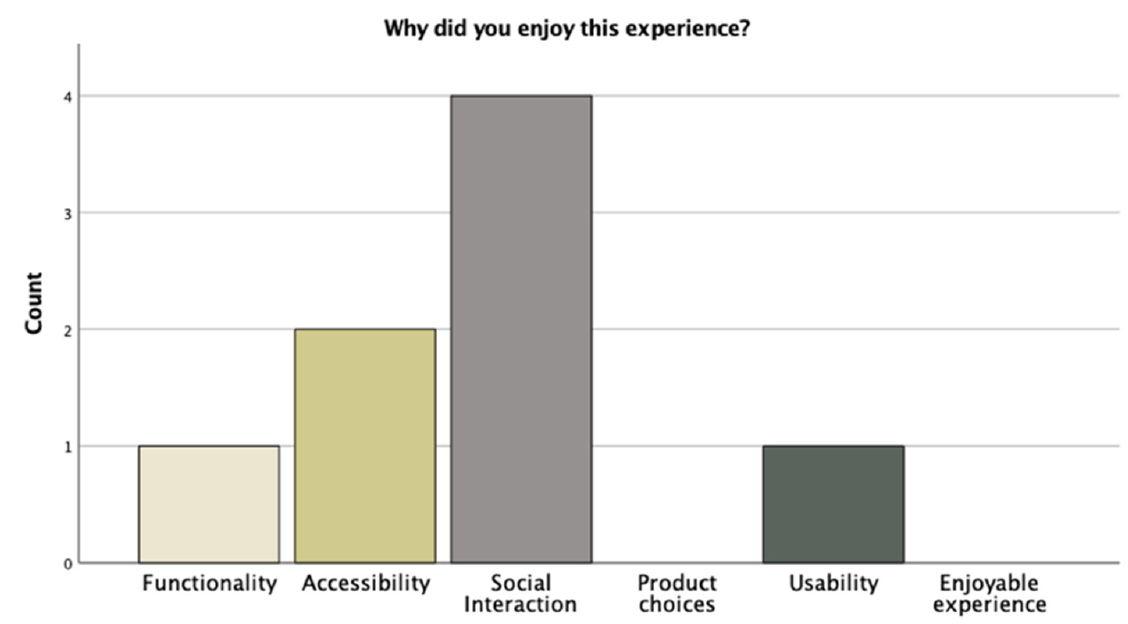
Figure 6. Responses to why respondents enjoyed their experience with live stream retailing.